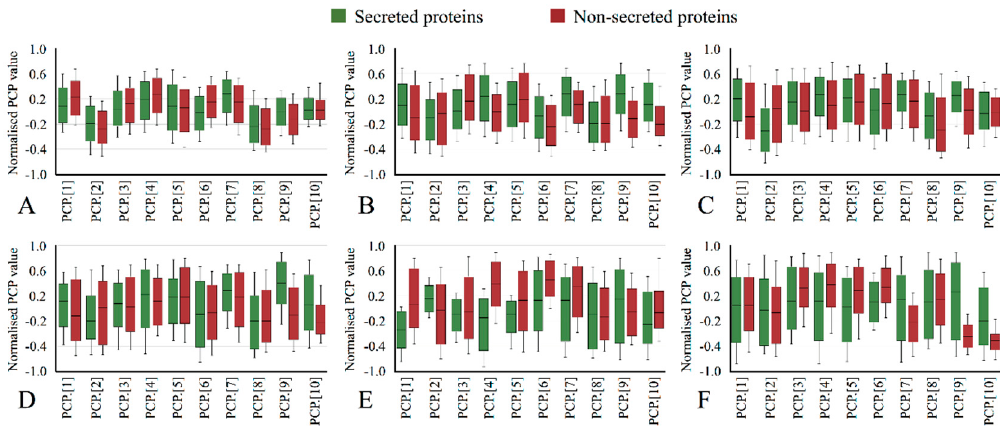
Figure 2. Physicochemical properties of secreted proteins and non-secreted proteins in ( A ) Secreted proteins (SPs)-all, ( B ) SPs- H , ( C ) SPs- M , ( D ) SPs- B , ( E ) SPs- C and ( F ) SPs- O . Physicochemical properties (PCP) represent hydrophobicity (PCP. [1]), polarity (PCP. [2]), solvation free energy (PCP. [3]), graph